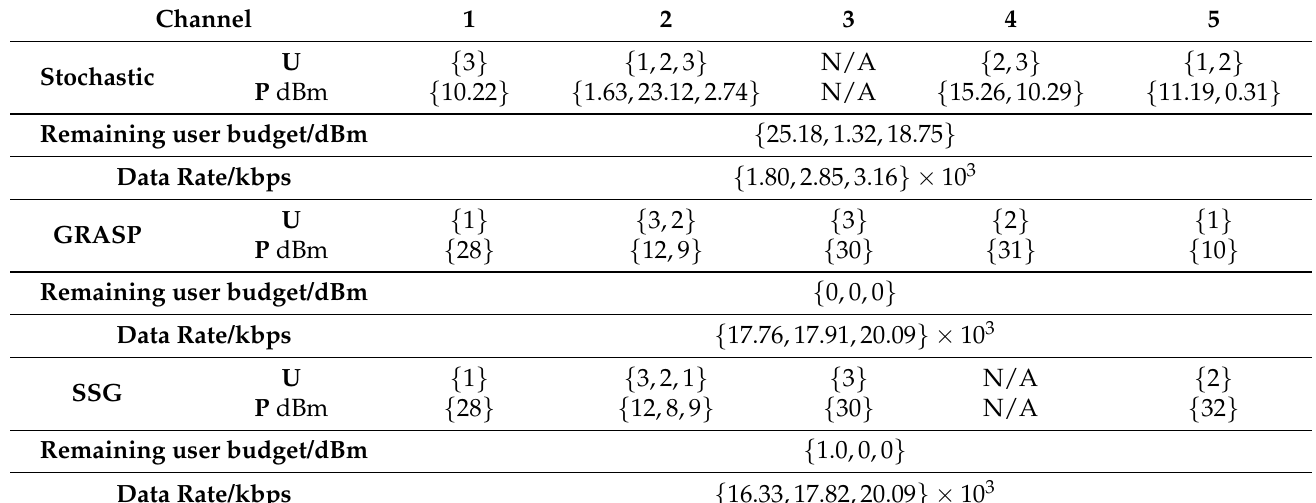
Table 2. Demonstration of DPCA allocation for MC-NOMA with heuristic solutions.